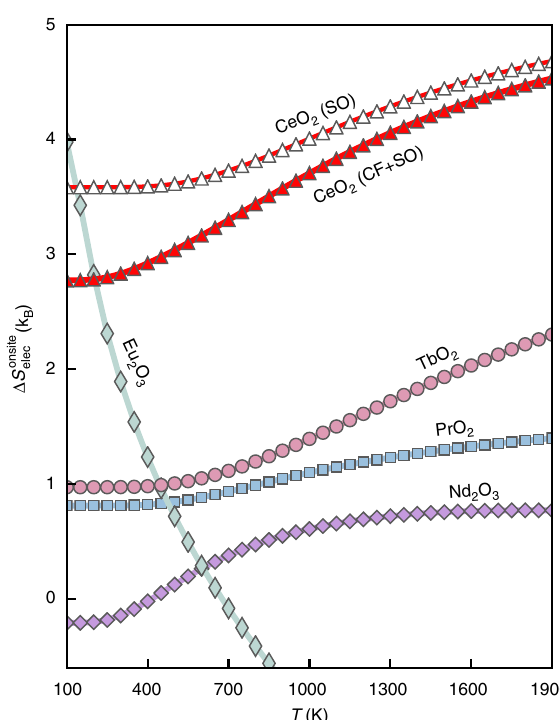
for lanthanides ions. Predicted electronic entropy Fig. 2 Calculated Δ S onsite elec of reduction per oxygen vacancy for the lanthanide oxides studied in this work. At high temperature, reduction of CeO 2 has the highest Δ S onsite followed by reduction of TbO 2 (see Table 1)